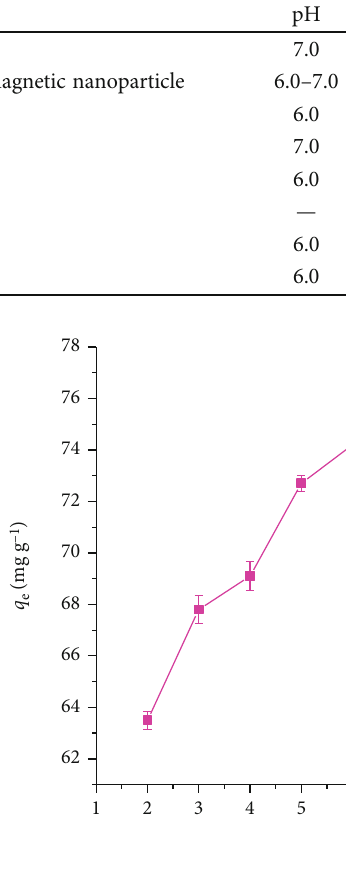
Figure 7: Solution pH impact on uptake of bisphenol A onto AgNP-SB- β CD nanocomposites ( C = 25 ° C, and t = 120